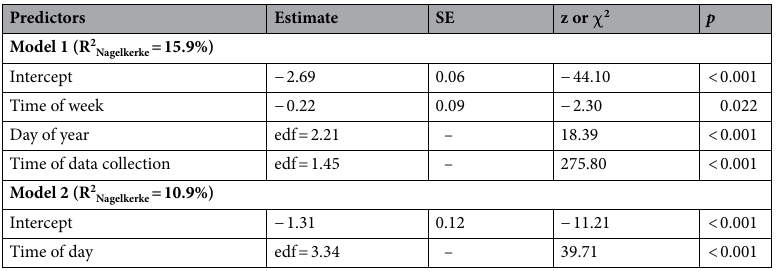
Table 1. Results of generalized additive models explaining probability of the red fox incidents in Warsaw. ‘Model 1’ analyzing the effect of time of week (weekdays vs. weekends), day of year (1–366) and time of data collection (a day in the period 1998–2015), on the probability of an incident with the red fox in Warsaw and the second one, ‘model 2’ analyzing the impact of time of day (hour) on the probability of fox incident. Estimated number of degrees of freedom, standard error, z or χ 2 statistics, p value and explanatory power of each model (R 2 Nagelkerke ) are